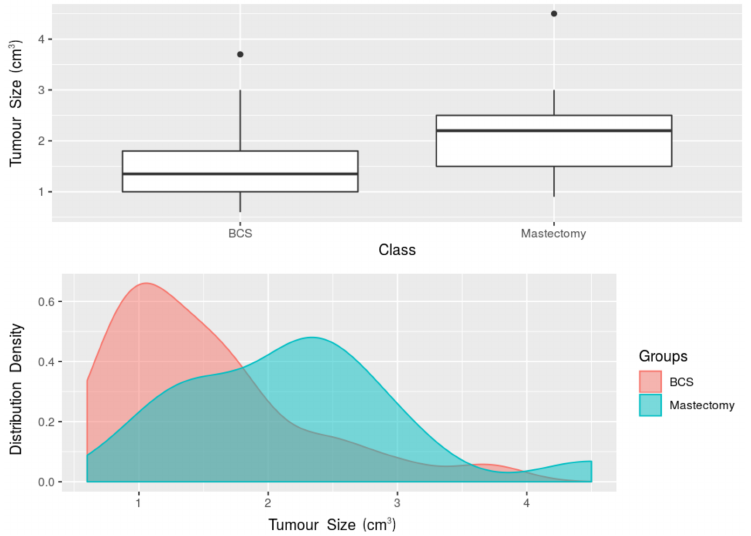
Figure 3. Boxplot and density plot for the comparison of tumour size at the final pathology between the women undergoing breast-conserving surgery and the women undergoing mastectomy. BCS, breast-conserving surgery.